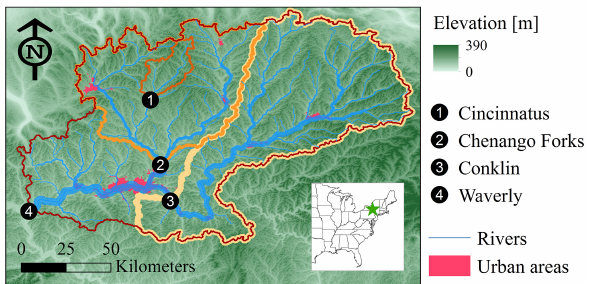
Figure 1. Map illustrating the location of the four selected river basins in the US middle Atlantic